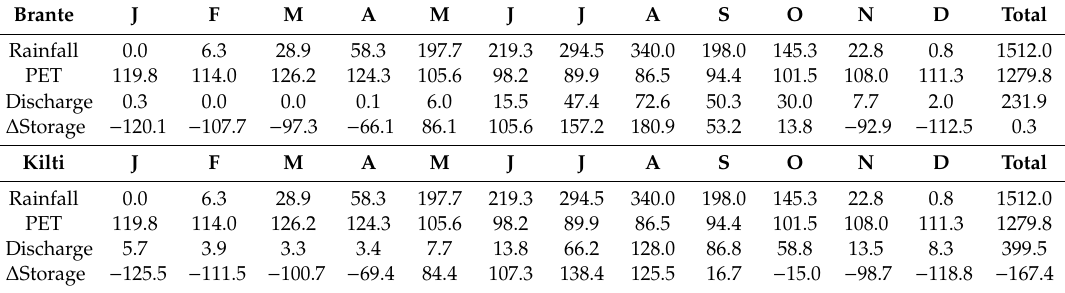
Figure 4. Time series from the citizen science hydrometeorological monitoring programme in Dangesheta kebele (Abadira kebele time series not shown). Top: river stage in the Kilti and Brante Rivers and rainfall. Bottom: groundwater levels in five wells (MW) and rainfall. Table 1. Mean monthly water balance for 2014–2018 for the Brante (66 km 2 ) and Kilti (165 km 2 ) catchments; note that both use rainfall and potential evapotranspiration (PET) from the Dangila NMA weather station (see Figure 1 for catchment locations). ∆ Storage is the change in total water storage in groundwater, soils, and surface water (i.e., inundated floodplains). All values provided as millimetre